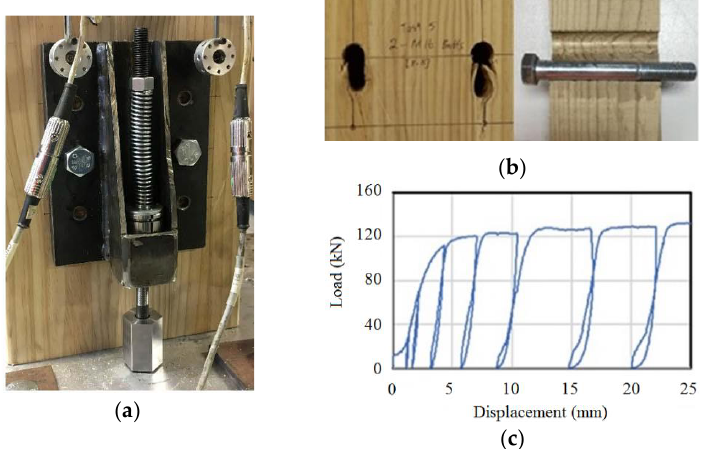
Figure 5. Pinching-free connectors: ( a ) as-built HD connector; ( b ) local failure with only crushing (photo credit: Nicholas Chan, reprinted with permission); ( c ) pinching-free load–displacement.